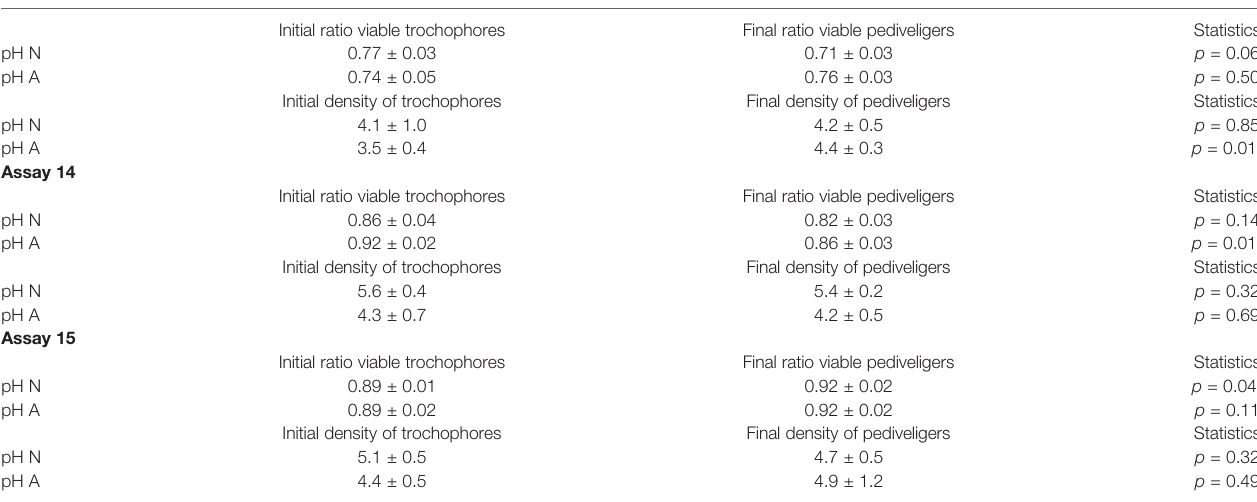
TABLE 2 | Validation of the larviculture protocol.